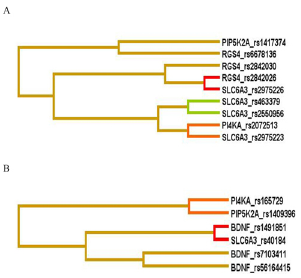
Figure 1. Interaction dendrogram generated from analysis of 53 polymorphisms by MDR method in patients with (A) low severity and (B) high severity of illness. A red or orange line indicates synergistic relationship; golden line represents additivity and blue or green shows redundancy. Short length arm of dendrogram indicates strong interaction. Footnote: MDR-Multifactor dimensionality reduction.